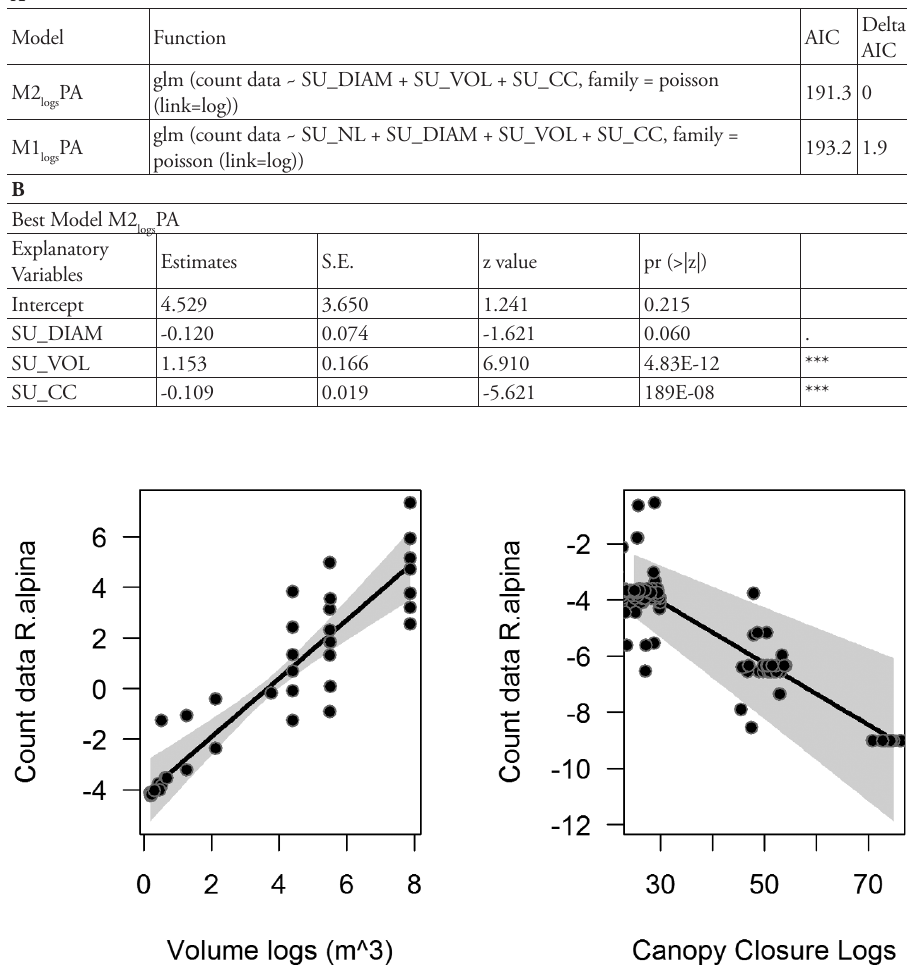
Figure 11. Significant environmental variables of the GLM models performed, on count data of R. alpina on logs in PA 2016. The number of individuals is positively correlated with log volume and negatively with canopy